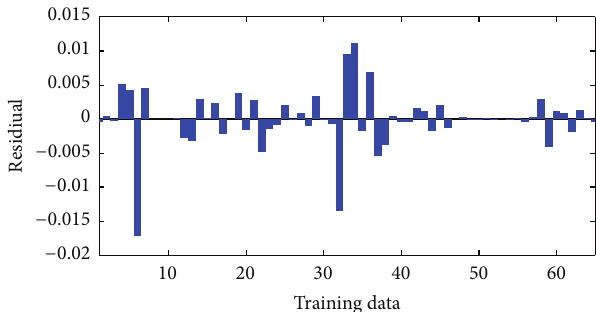
Figure 6: Residuals between ANN and experimental data for training